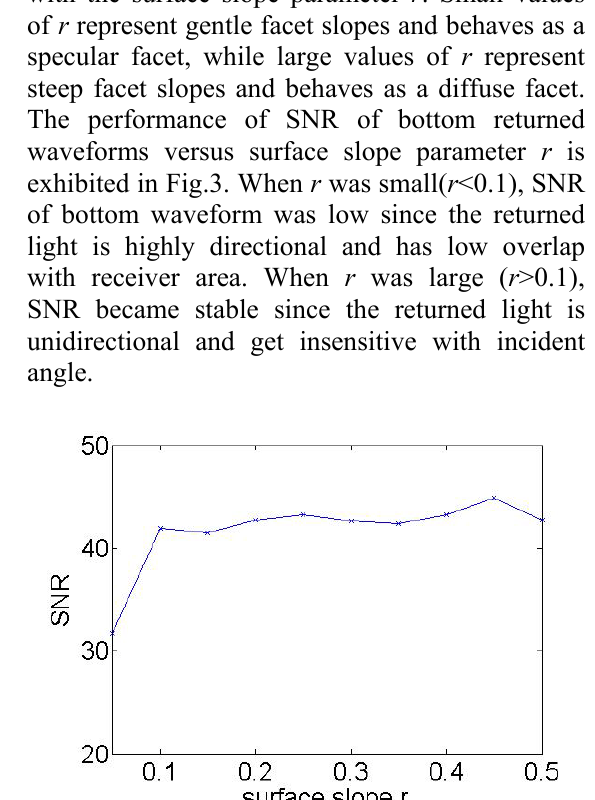
4mg / m C = , ph Fig.3 SNR of the bottom returned waveform vs. surface slope